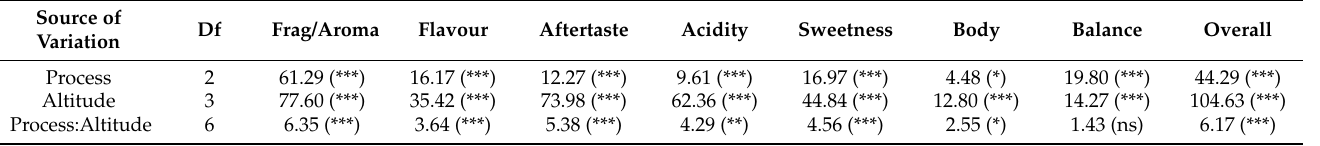
Table 4. Summary of F-values from analysis of variance (ANOVA) for conilon according to sensory attributes.